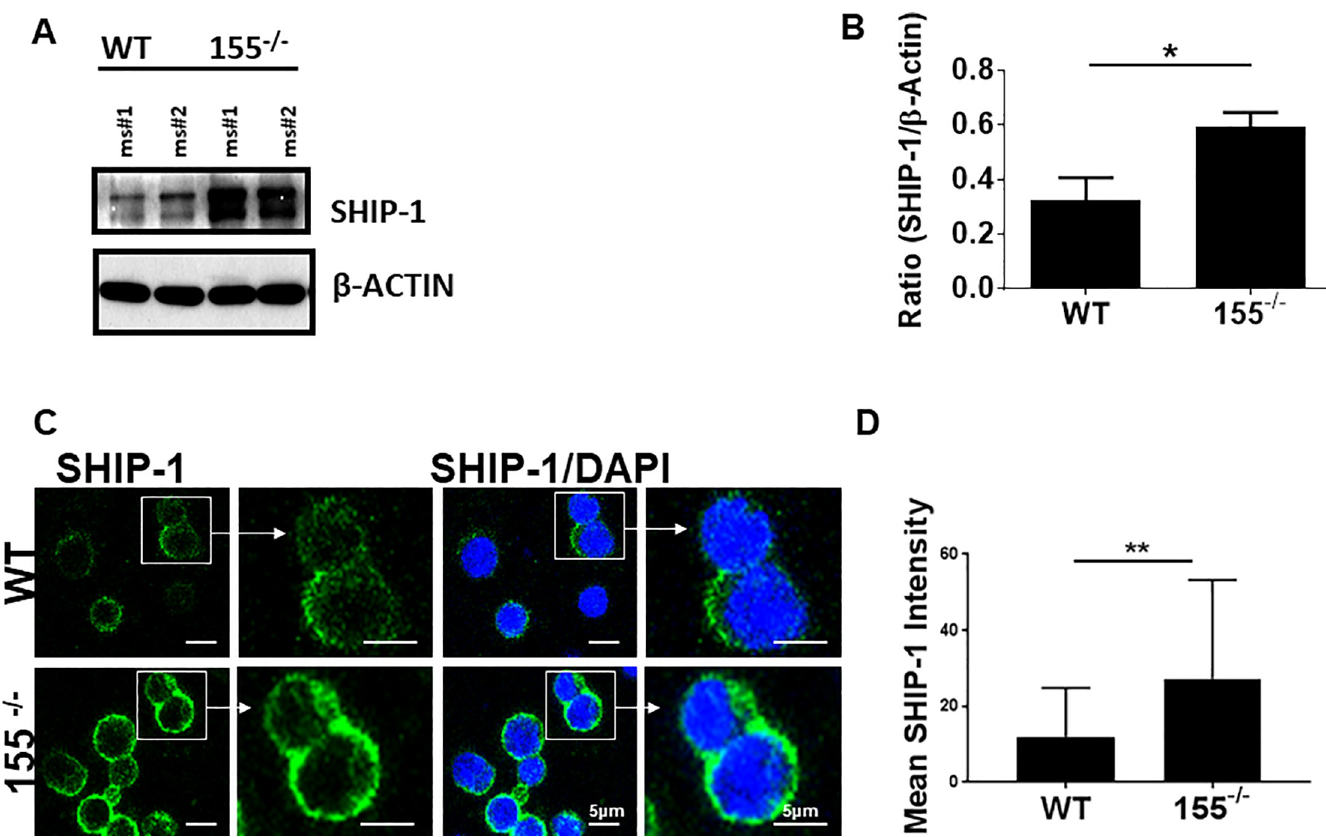
Fig 1. miR-155 -/- NK cells overexpress SHIP-1 and do not polymerize actin. IL-2 activated NK cells were generated from purified splenic wild-type or miR-155-/- NK cells. A) SHIP-1 immunoblot analysis of wild-type (lanes 1–2) or miR-155 -/- (lanes 3–4). IL-2 activated NK cells were derived from four mice per strain. B) Quantification of the mean ratio of SHIP-1 to actin from densitometry of immunoblots. C) IL-2 activated NK cells immunostained for SHIP-1. Data shown is a representative of three experiments performed unless otherwise stated. D) Quantification of mean SHIP-1 membrane intensity from confocal microscopy as in panel